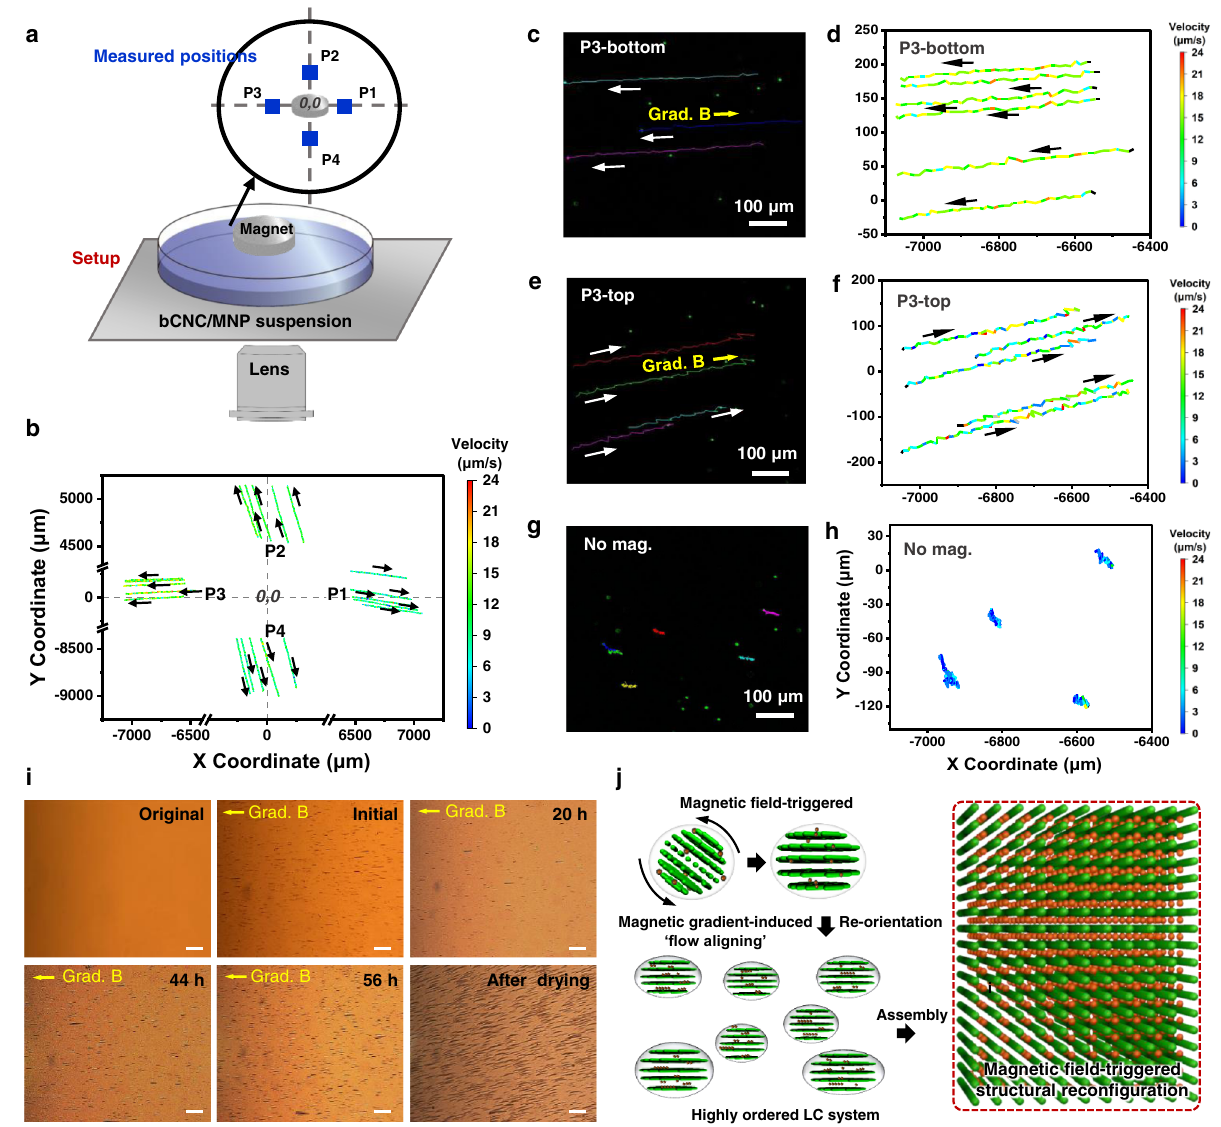
Fig. 5 | Real-time magnetic fi eld induced fl ow behavior during the assembly process. a Schematic illustration of CLSM measurement setup and captured positions (four blue spots denoted as P1 – P4). b Trajectories and velocity distribu- tionsofthebeadslocatedatP1 – P4intheheightof100 μ mfromthebottom.Tracks andvelocitiesofbeadslocatedatP3withdifferentheights,thebottomlayer( d ),the toplayer( f ),andcorrespondinglyopticalimageswithtrackingmarksatbottom( c ) and top ( e ), the white arrow indicated the beads moving directions, the yellow